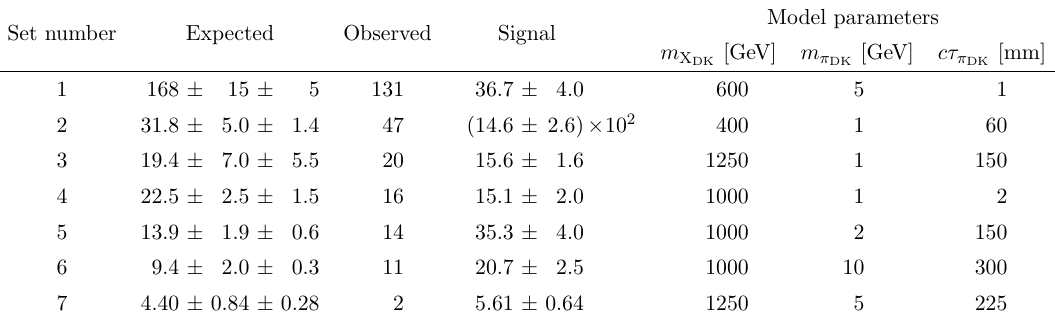
Table 6 . Expected (mean (cid:6) syst (cid:6) syst ) and observed event yields for each selection set. Uncer- 1 2 tainties due to the limited number of events in the control sample and statistical uncertainties in the misidenti(cid:12)cation probabilities are denoted by \syst 1 ", while \syst 2 " combines the systematic uncertainty sources discussed in table 4. The \Signal" column shows the expected event yield for the heaviest mediator mass that can be excluded for each set, with the systematic uncertainties from sources discussed in table 5 summed in quadrature. The associated model parameters are speci(cid:12)ed in the last three columns.